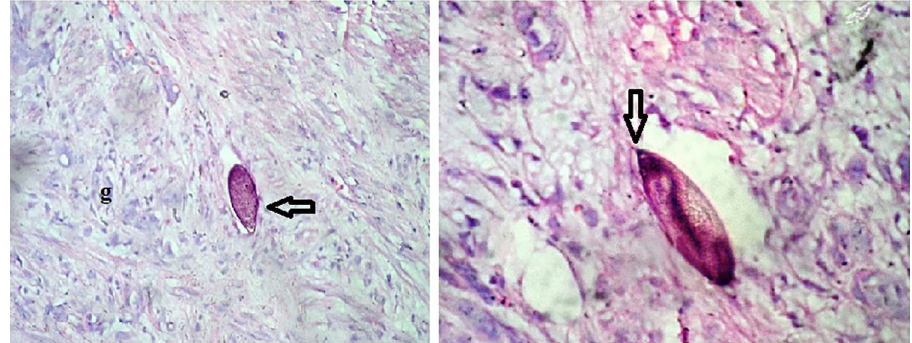
Fig 4. UC showing loose granulomas (g) around terminally spined S . haematobium eggs (black arrow) stained with H&E ( × 200).